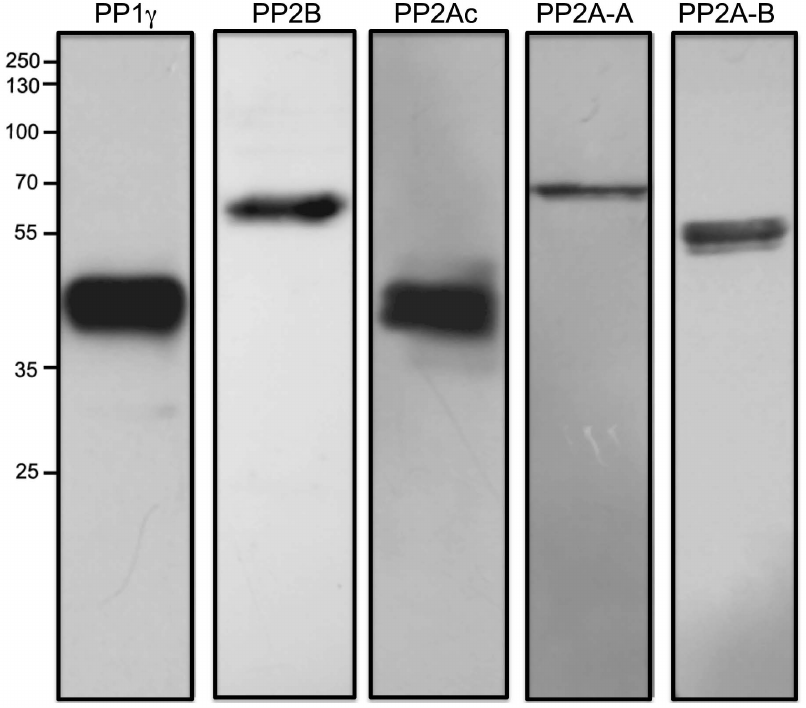
Figure 1. Presence of PP1 c , PP2B, and PP2A in human sperm. Twenty-microgram samples of sperm extracts were subjected to SDS-PAGE and then transferred onto a PVDF membrane. The membrane was then probed with anti PP1 c (PP1 c ), anti-PP2B a (PP2B), and with an antibody sampler kit anti PP2A (PP2Ac, PP2A-A, PP2A-B). The western blot depicted is a representative experiment repeated at least three times. Molecular mass is indicated at the